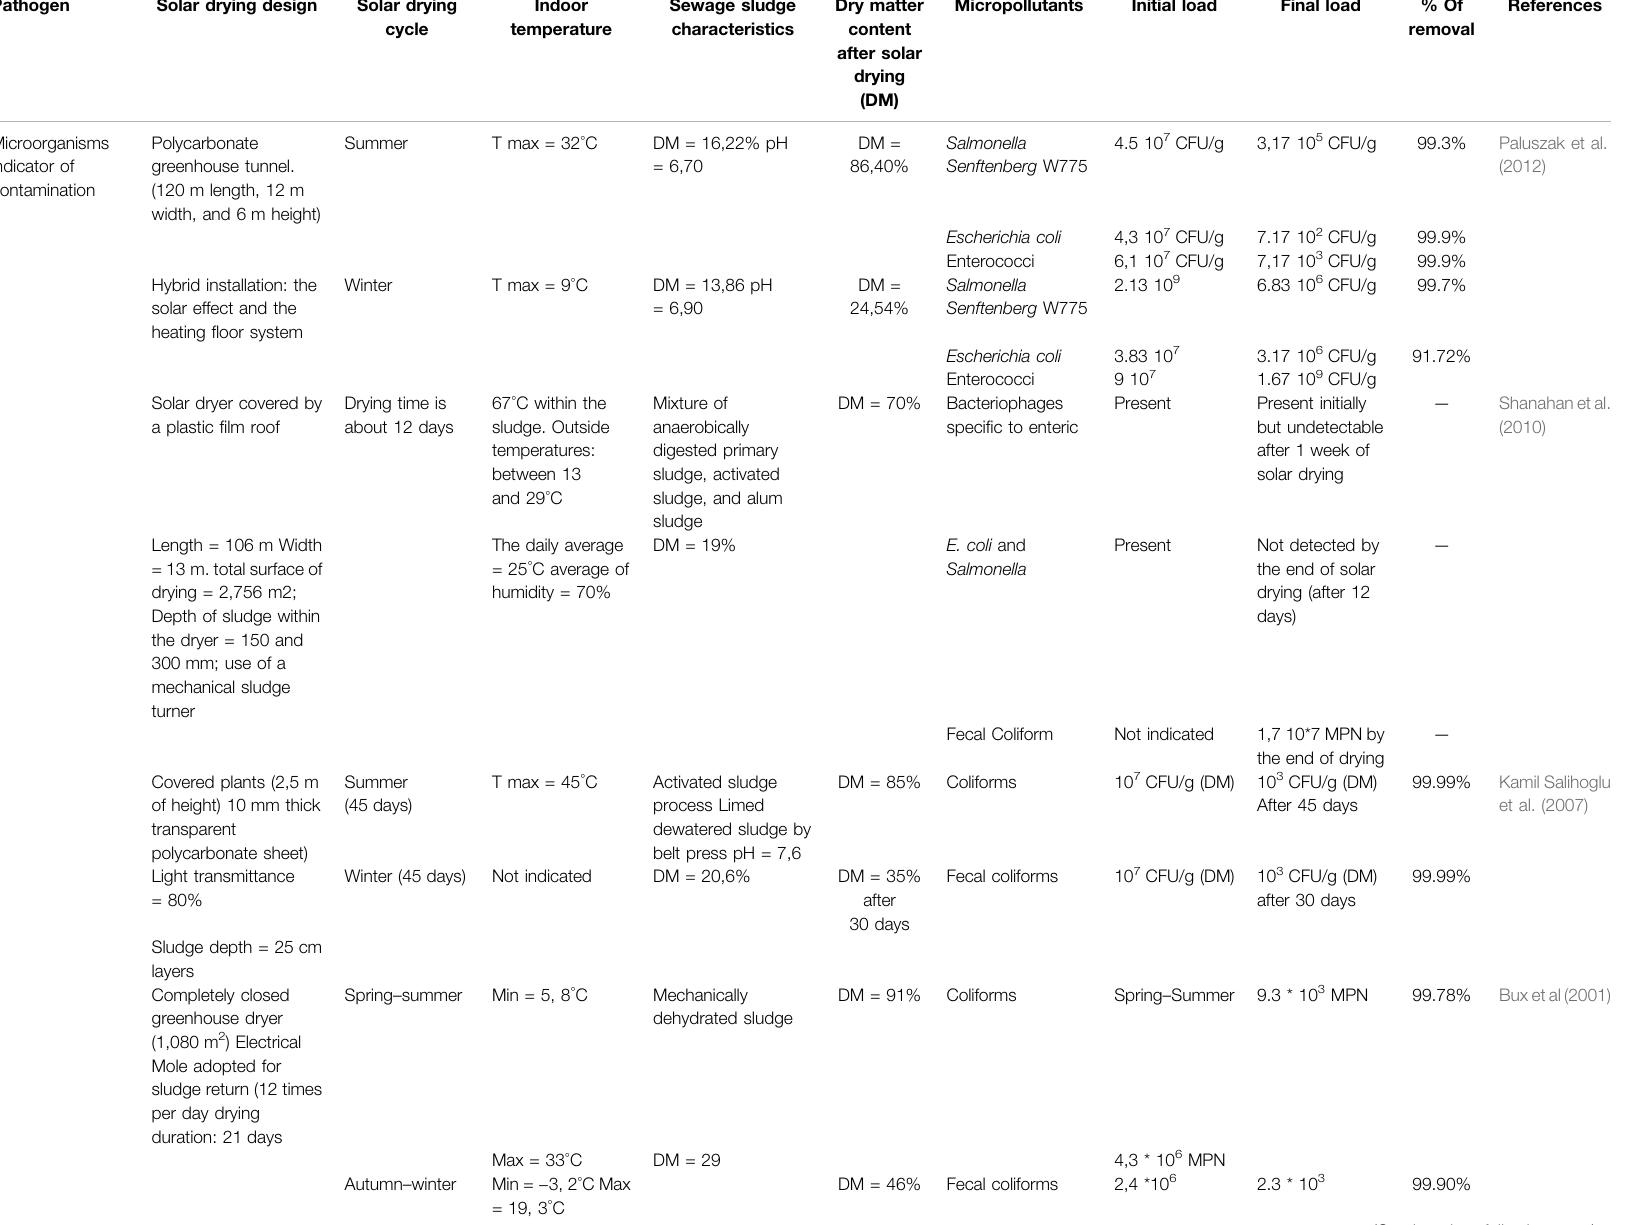
TABLE 8 | Impact of the solar drying process on pathogens in sewage sludge.